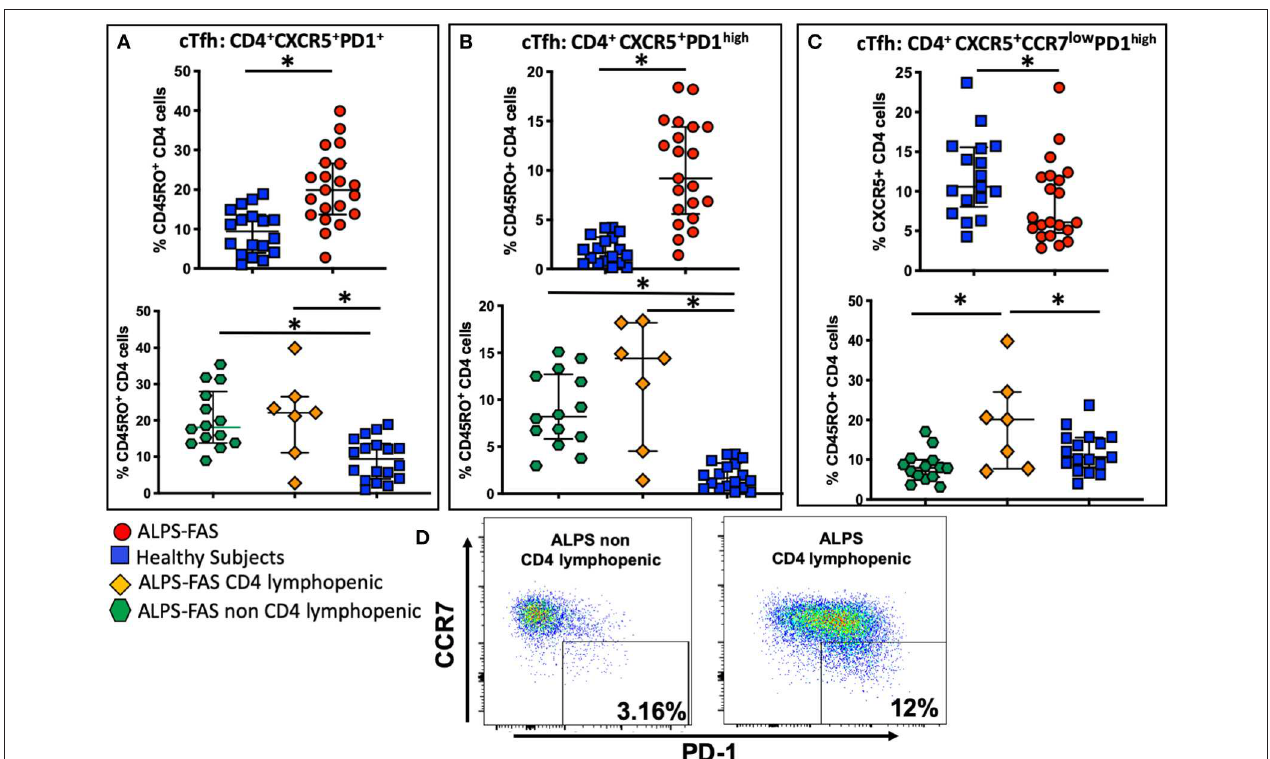
FIGURE 7 | Circulating T follicular helper cells (cTfh) and theirs subpopulation in health subjects (blue square), ALPS-FAS subjects irrespective of CD4 cell counts (red circles), ALPS-FAS with CD4 lymphopenia (orange diamond), and ALPS-FAS without CD4 lymphopenia (green hexagon). *Comparisons with statistically significant differences. (A) Proportion of total cTfh cells (CD4 + CD45RO + CXCR5 + ). (B) Proportion of activated Tfh (CD4 + CD45RO + CXCR5 + PD1 high ). (C) Proportion of a CCR7 low expressing cTfh (CD4 + CD45RO + CXCR5 + CCR7 low PD1 high ). (D) Representative scatter dot plot flow-cytometry panel highlighting the expansion of